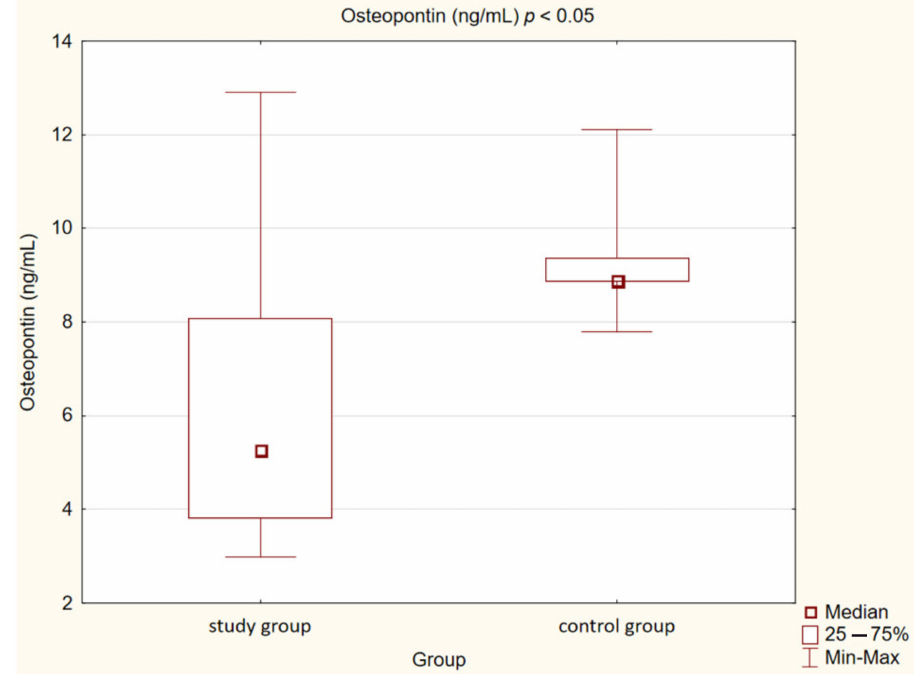
Figure 5. Concentration of osteopontin (OPN) in study and control group.